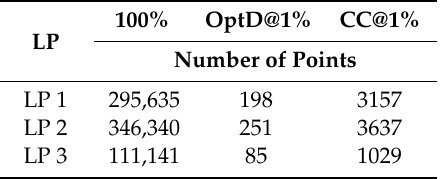
Table 5. E ff ect of data reduction on points far from LPs.